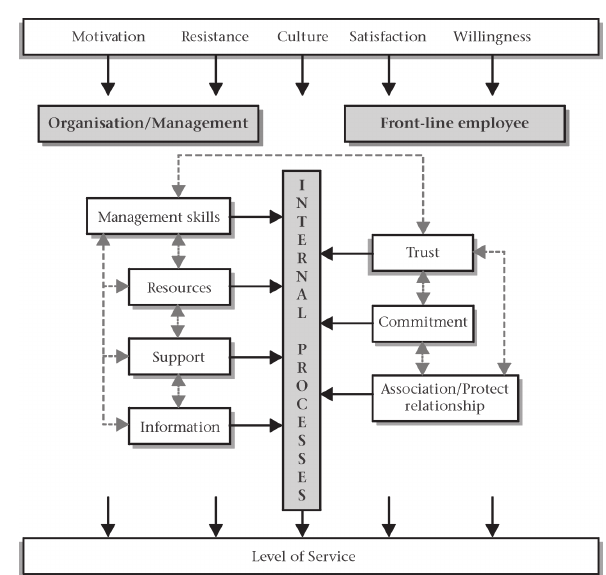
Figure 2: Process satisfaction model